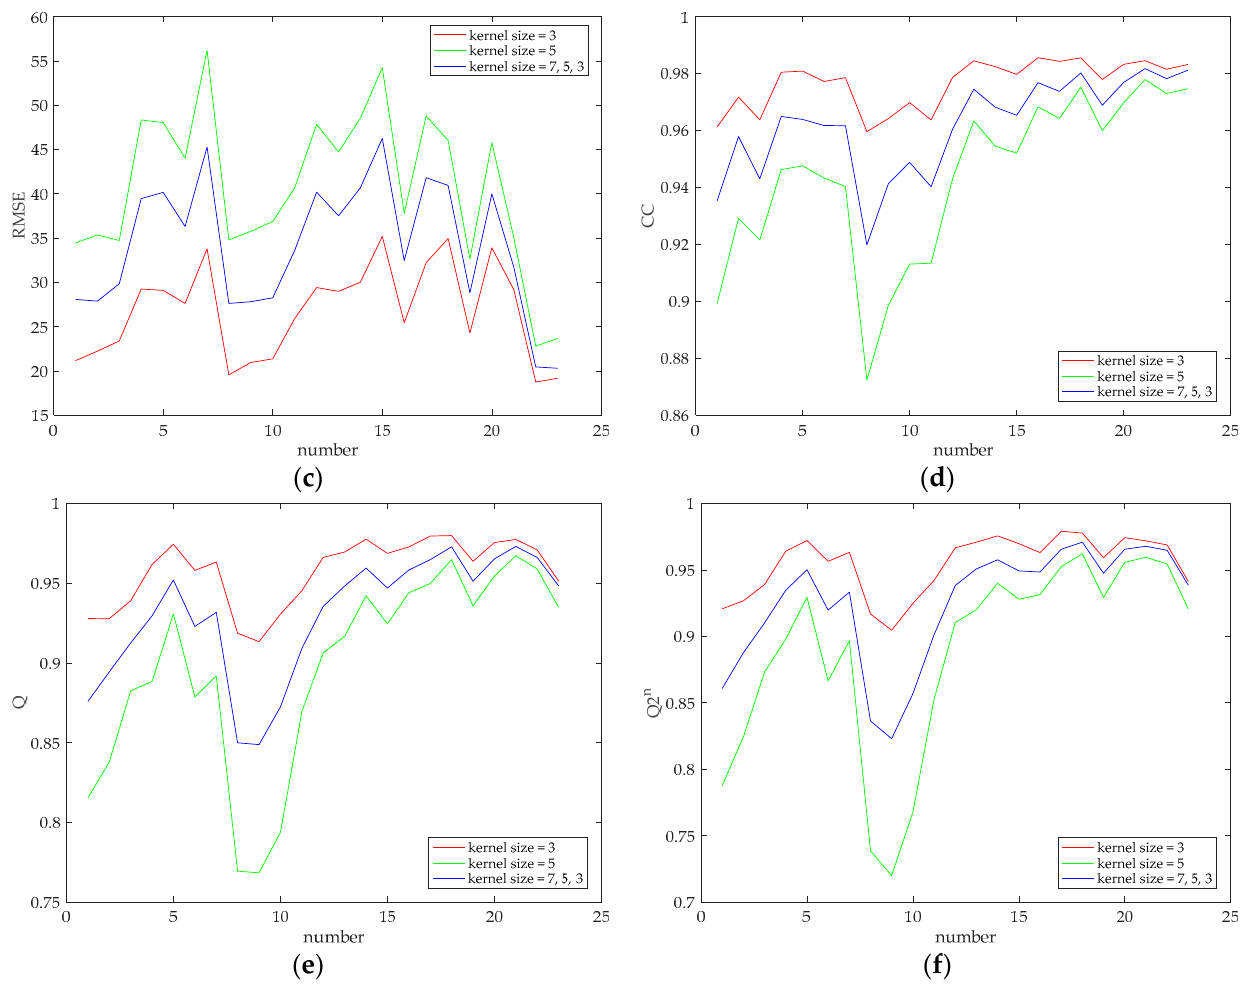
Figure 5. Quality Indicator curves of different convolution kernel sizes (evaluated on 23 groups of test images of QuickBird dataset). ( a ) SAM; ( b ) ERGAS; ( c ) RMSE; ( d ) CC; ( e ) Q; ( f ) n Q2 .